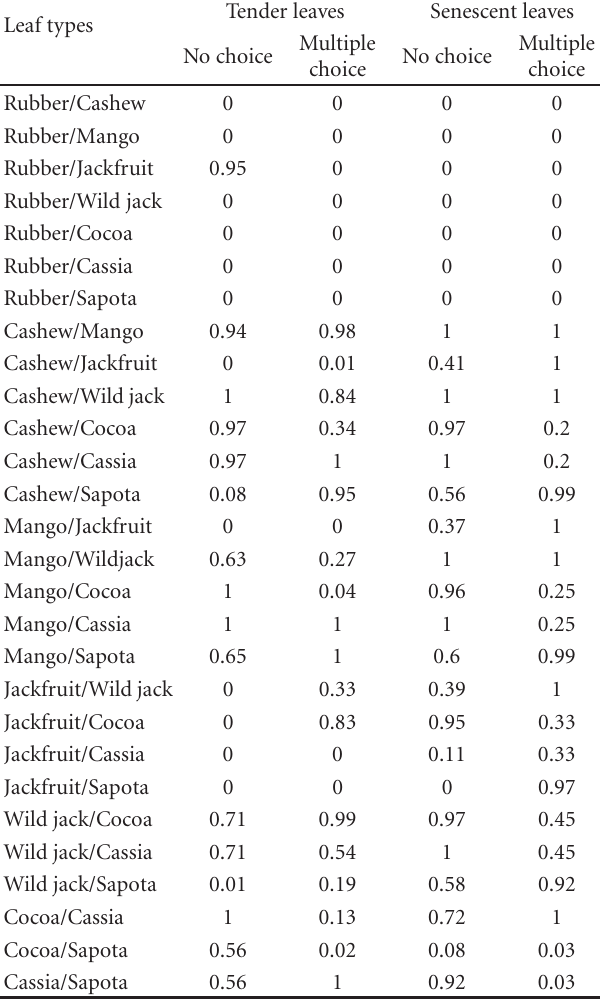
Table 5: Preference hierarchy of L. tristis to various leaf types and leaf ages. Leaf